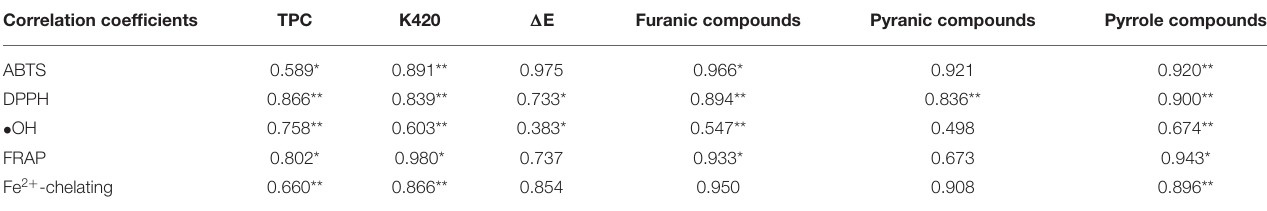
TABLE 2 | Correlation analysis between physiochemical characteristics and antioxidant activities. Correlation